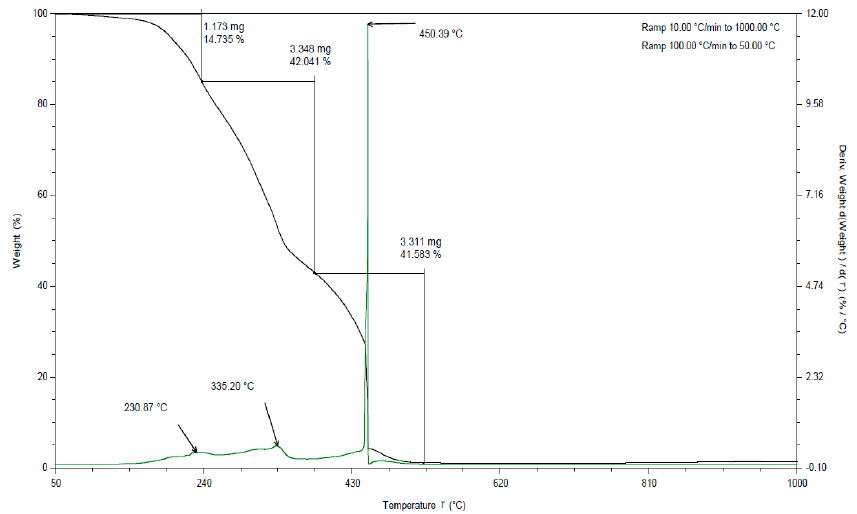
Figure 7. TGA curve for apple pomace dried at 60 °C. Analysis under oxygen atmosphere (black line is a curve of mass loss versus temperature, green line is the first derivative).